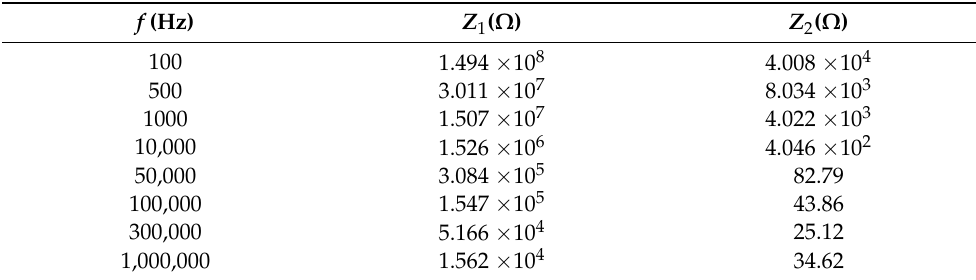
Table 8. Modules of the obtained primary ( Z 1 ) and secondary ( Z 2 ) impedances for LPVT B at 10 V at room